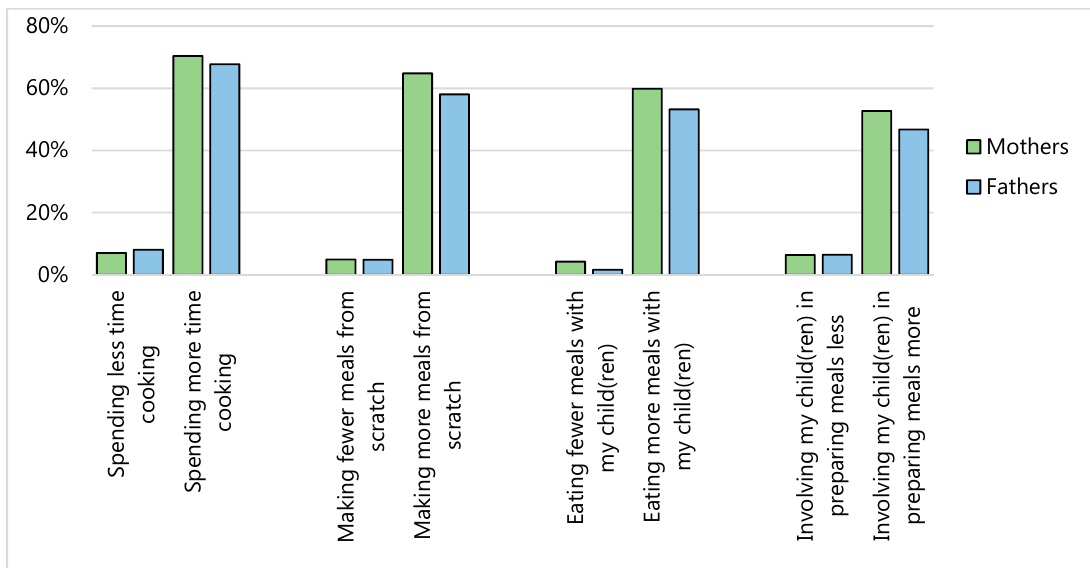
Figure 1. Change in eating behaviors among mothers ( n = 166), fathers ( n = 74), and children ( n = 159) since COVID-19.